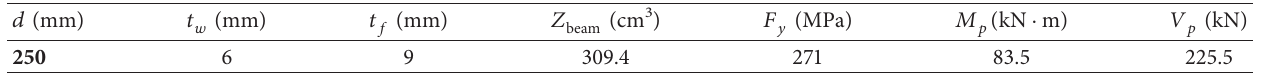
Table 5: M P and V P of links.